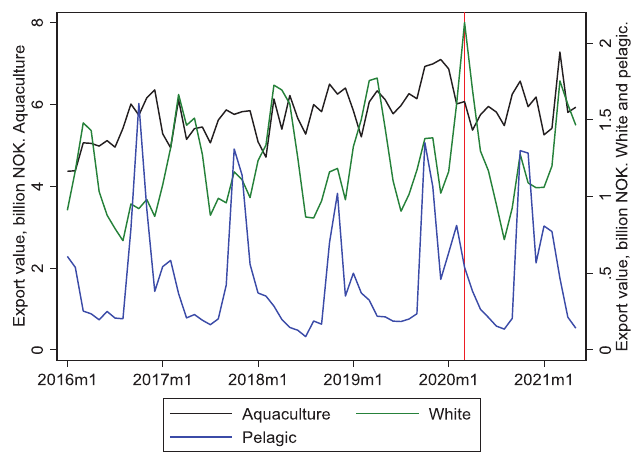
Fig. 1. Monthly export value. January 2016 – May